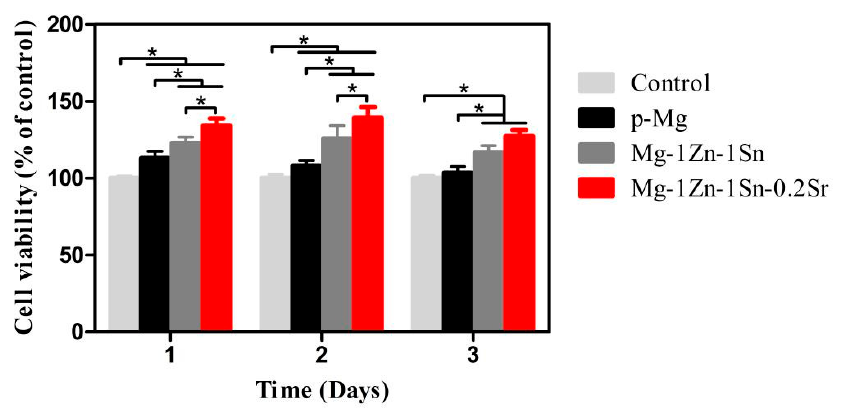
Figure 6. Cell viability of MC3T3-E1 cells cocultured with extracts for 1, 2 and 3 days. Values are mean ± SD, n = 3, * p < 0.05.